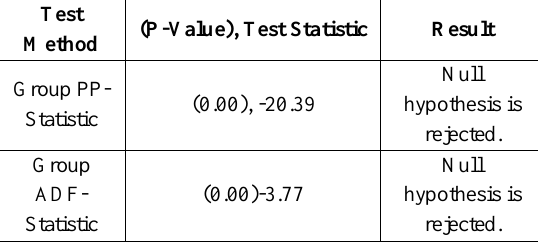
Table 2: Pedroni cointegration test results Test Method